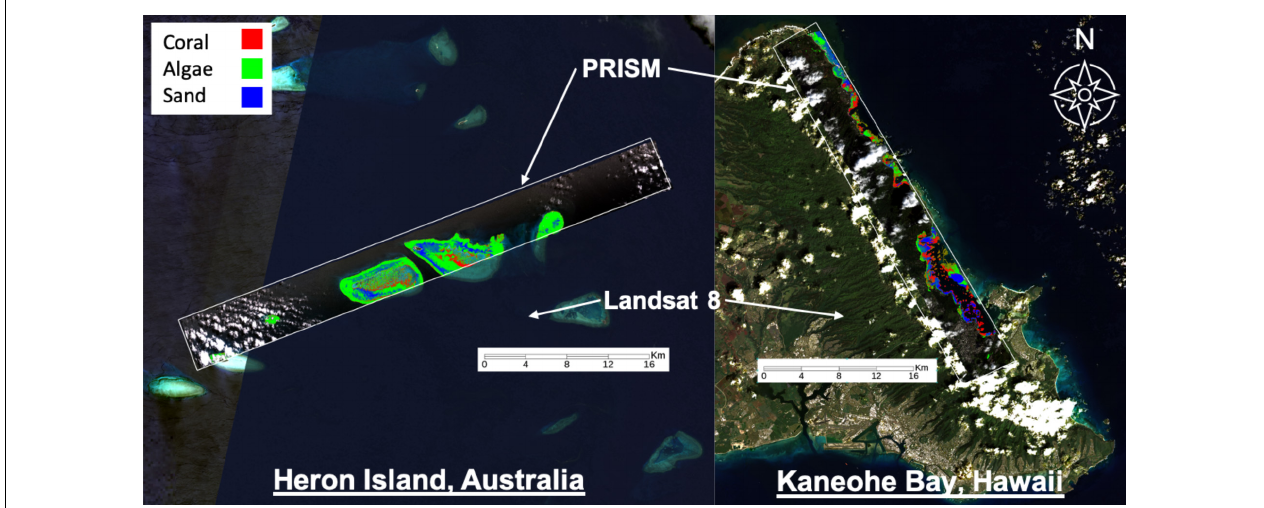
FIGURE 1 | Remote sensing data used for this study. Landsat 8 data provides global-scale coverage but at coarse spatial and spectral resolutions that are often insufficient for benthic cover analysis. PRISM is an airborne imaging spectrometer with finer spatial and spectral resolution that was used by the CORAL mission to discriminate benthic functional types. The CORAL mission focused on three benthic functional types – coral, algae, and sand – and thus only these three types are considered herein (as shown). Coral (red), algae (green), and sand (blue) abundance maps were estimated by Thompson et al. (2017) and validated by the CORAL mission with photomosaics collected in the